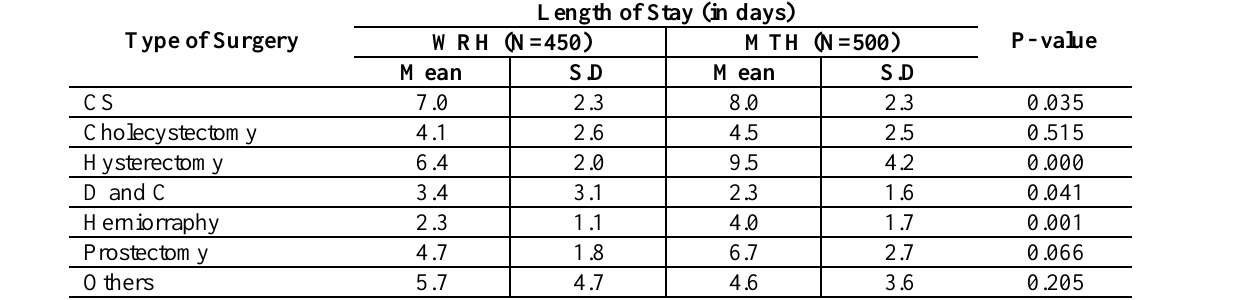
Table II : Length of Stay according to type of